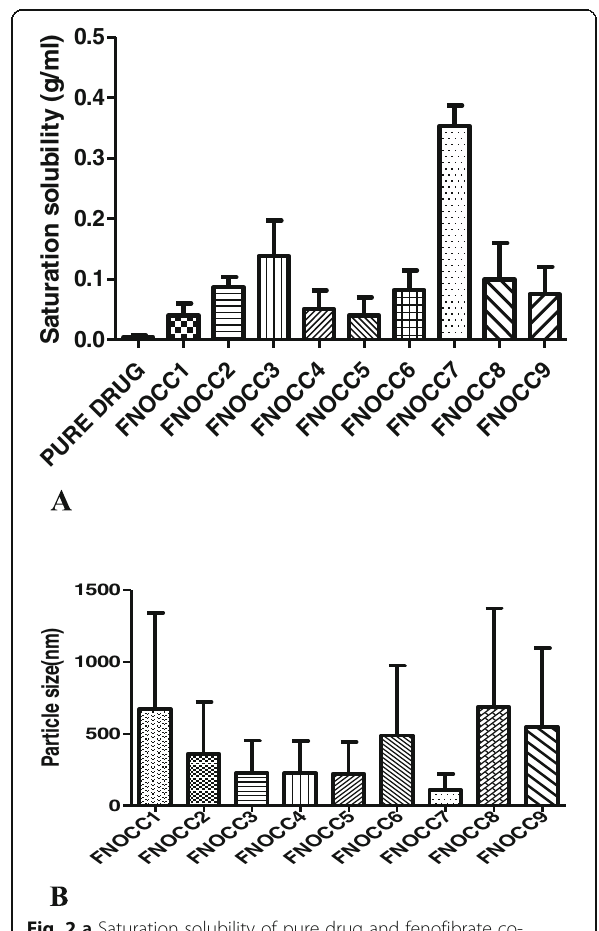
Fig. 2 a Saturation solubility of pure drug and fenofibrate co- crystals. b Particle size distribution of fenofibrate